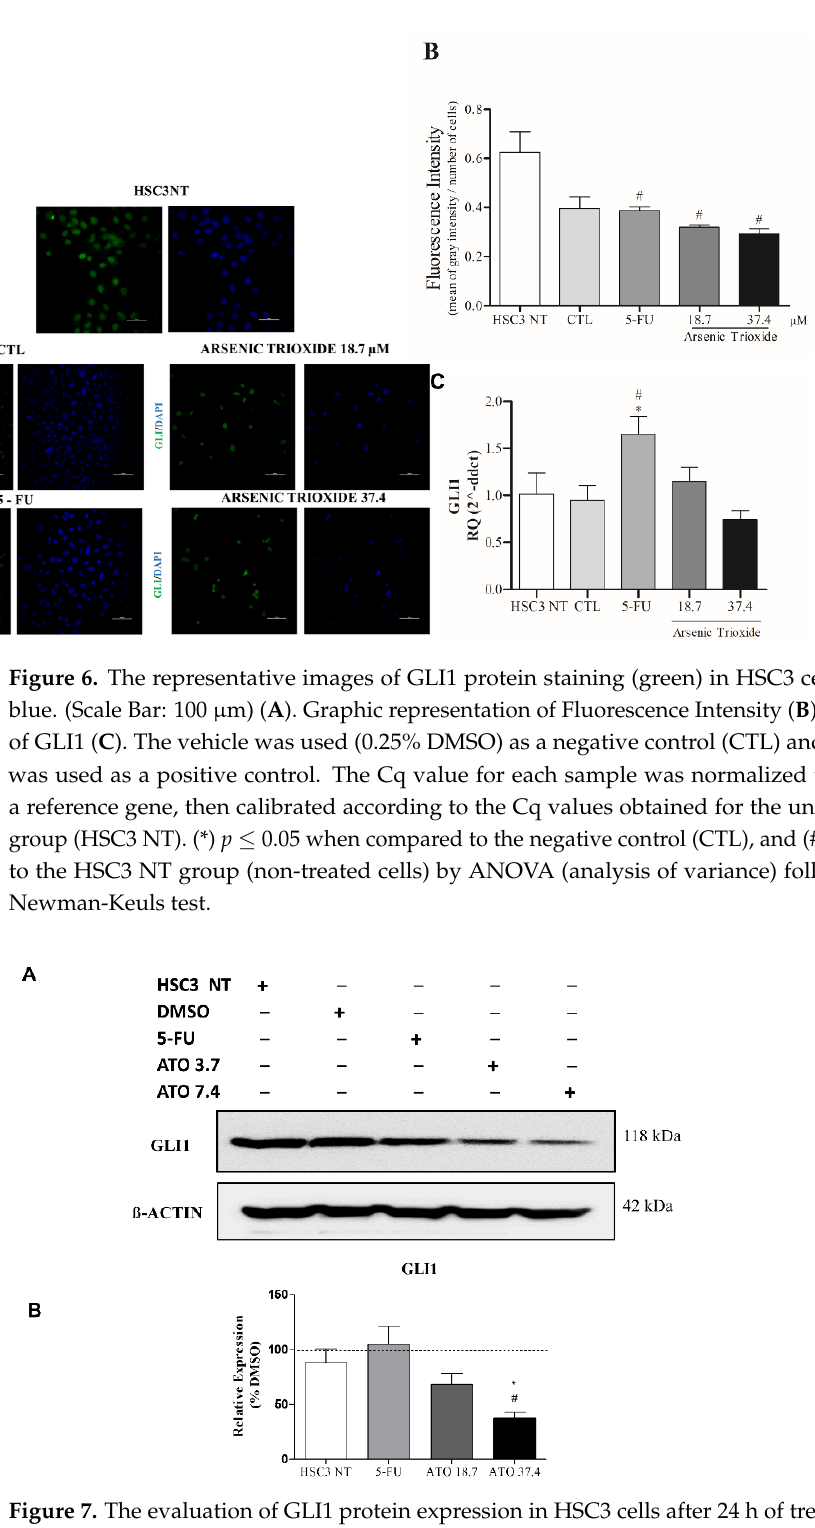
Figure 7. The evaluation of GLI1 protein expression in HSC3 cells after 24 h of treatment with ATO. ( A ) Low GLI1 protein expression levels in HSC3 cells treated with ATO. The symbol ( − ) represents the absence and (+) represents the experimental group in each band in the following order: HSC3 NT (non-treated), DMSO, 5-FU, ATO 3.7 µ M and ATO 7.4 µ M. ( B ) Graphic representation of densitometry readings of three individual experiments. The value of each experimental condition was calibrated using GLI1/ß-actin intensity ratio and then DMSO (—) was used as the reference group. (*) p ≤ 0.05 when compared to HSC3 NT (non-treated cells) group and (#) when compared to 5-FU by ANOVA (analysis of variance) followed by Student Newman-Keuls